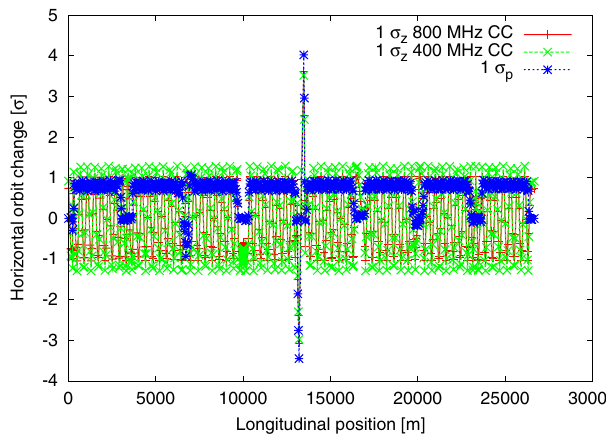
FIG. 10. (Color) Comparison of horizontal orbit change of a particle with 1 (cid:3) z offset for 800-MHz global crab-cavity case (red); of a particle with 1 (cid:3) z offset for 400-MHz global crab- cavity case (green); and for a 1 (cid:3) p off-momentum particle (blue), in the lowbetamax collision optics. The orbit change due to the crab cavity is comparable to, or smaller than, the dispersive orbit shift.